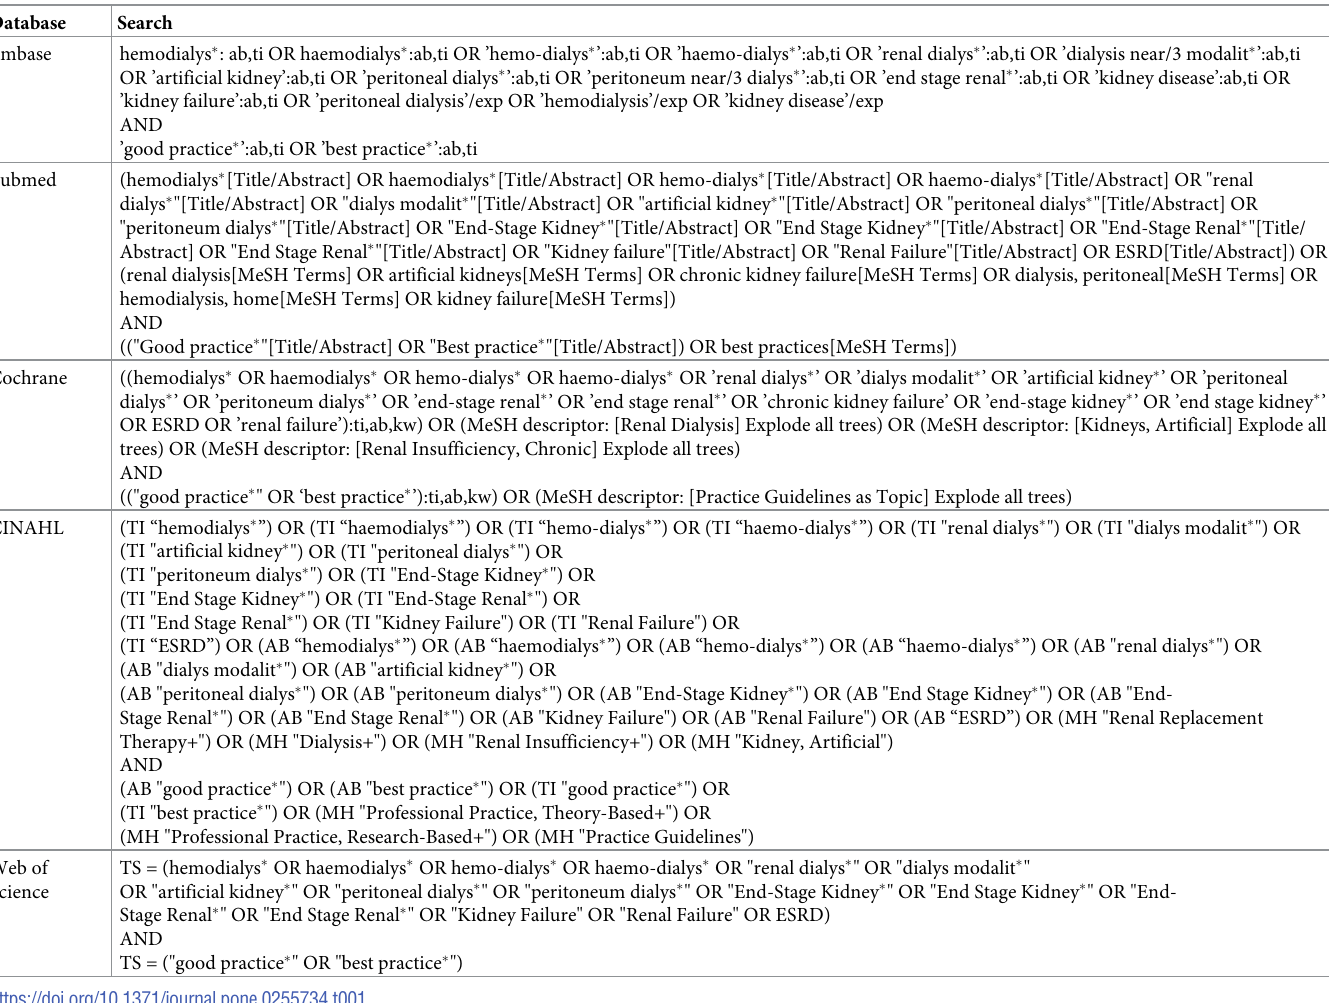
Table 1. Search strings. Database Search